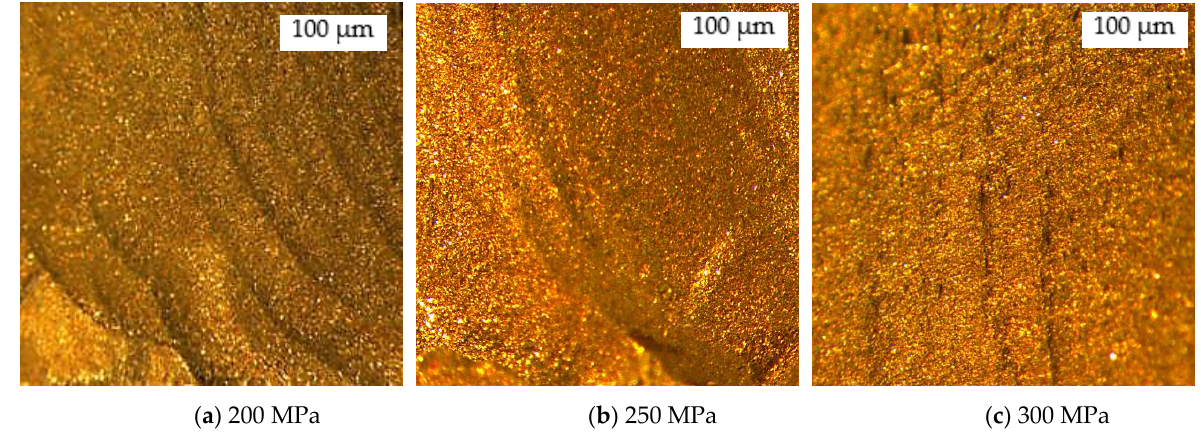
Figure 8. Topography of AISI 304L cut surface with 8 mm thickness using varied waterjet pressure.